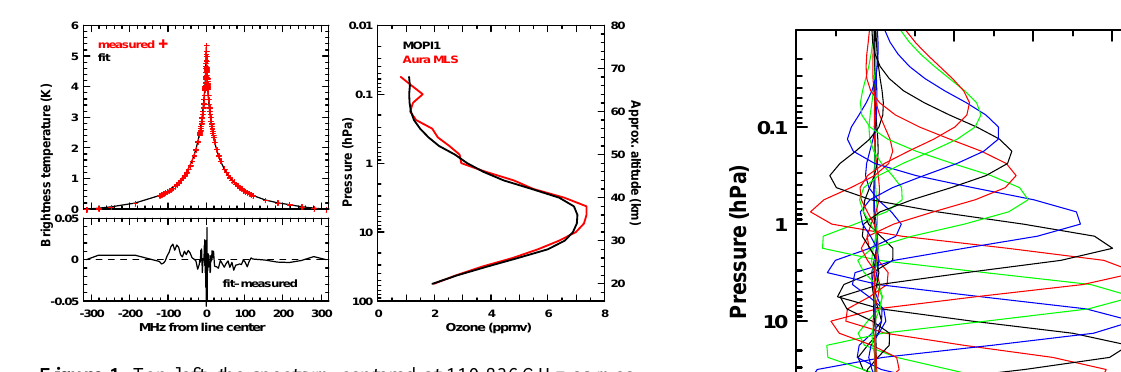
Figure 1. Top left: the spectrum centered at 110.836GHz as mea- sured by MOPI1 from Lauder over 3h on 11 March 2014 (red crosses), and the model fit to this spectrum (black line). Bottom left: the residual difference between the measured and modeled spec- trum. Right: the retrieved O 3 profile from MOPI1 (black) and from a coincident Aura MLS measurement (red).